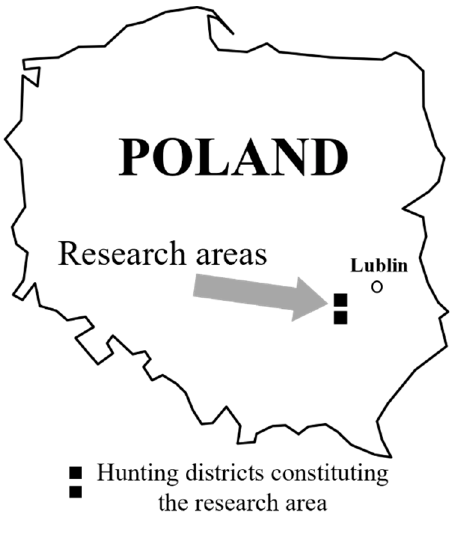
Figure 1. Location of the research